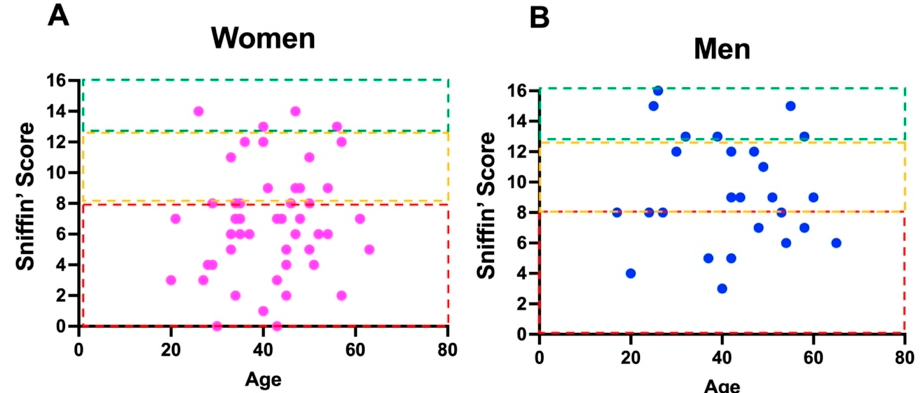
Figure 1. ( A ) Distribution for age of different Sniffin’ scores in women. ( B ) Distribution for age of different Sniffin’ scores in men. The boxes in red, yellow, and green color represent the normal range for general population in term of normality, hypofunction or absence of smell capacity. Dots in the red boxes are indicative of anosmia, in the yellow are of hyposmia, and in the green are of normosmia. The reference value for normal olfactory scores refers to the data published by Oleszkiewicz et al. [14].